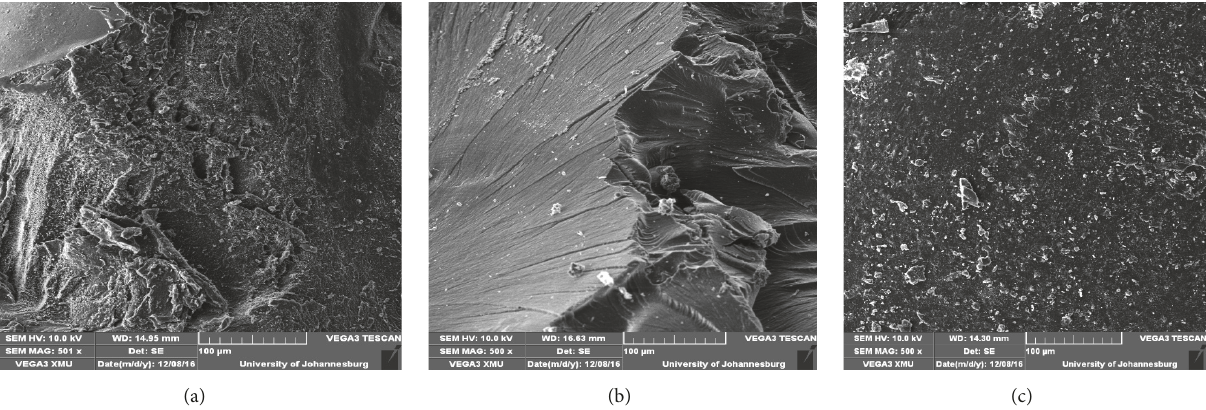
Figure 4: SEM analysis of chitosan, cross-linked chitosan, and grafted cross-linked chitosan beads,